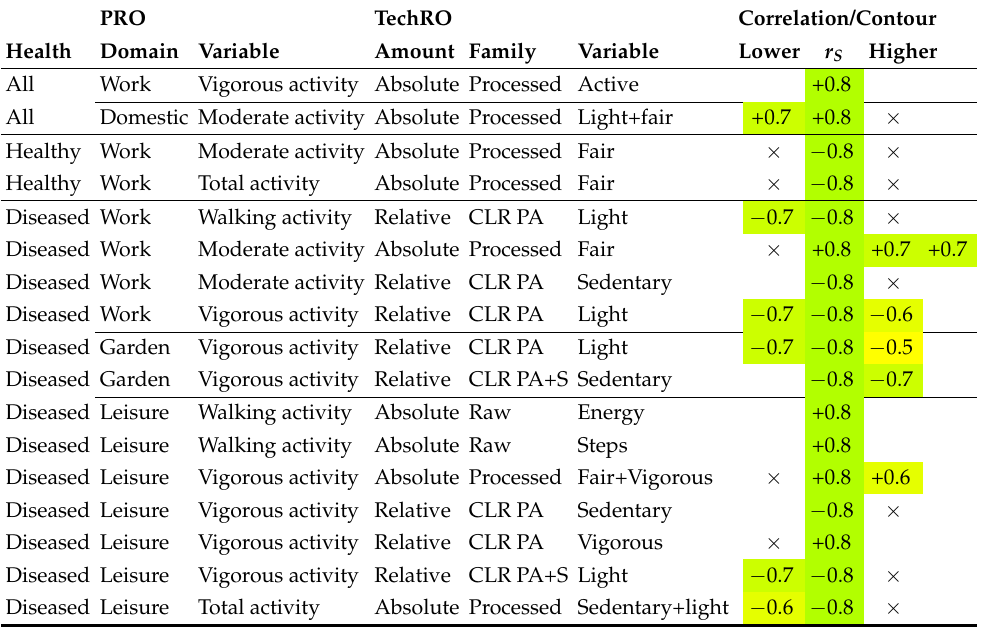
(Table 7, rows with Health: Diseased and TechRO Variable: Sedentary). Table 7. Summary of strong and significant Spearman rank correlations ( r S physical activity (IPAQ scale) and TechROs (Fitbit